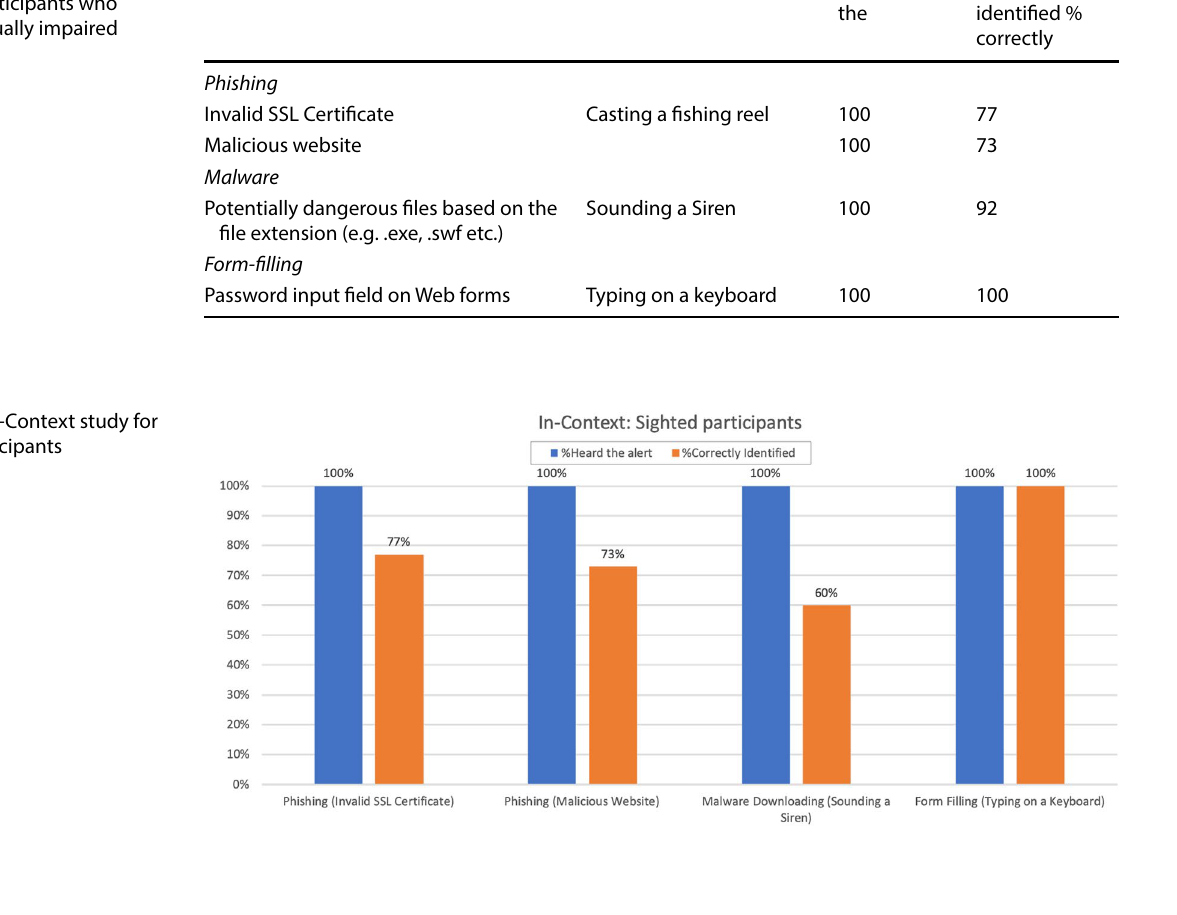
Table 6 Results of “in-context” study for participants who